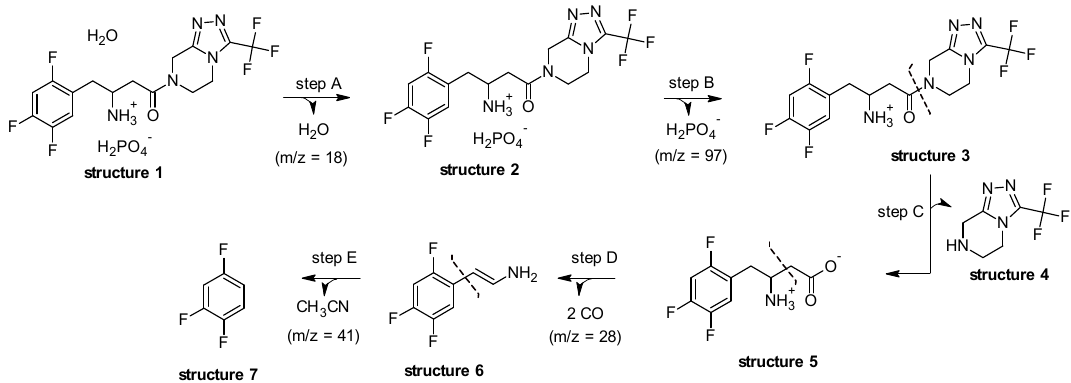
Figure 6. Proposal for the thermal decomposition of sitagliptin phosphate monohydrate. As seen from the results obtained in the thermogravimetric analysis, the initial mass loss for structure 1 is associated with dehydration of the compound (step A), which was confirmed by TG– MS, since m/z = 18 (H 2 O) has a higher intensity at 117 °C. Subsequently, in structure 2 can be seen the release of phosphate group (Step B).